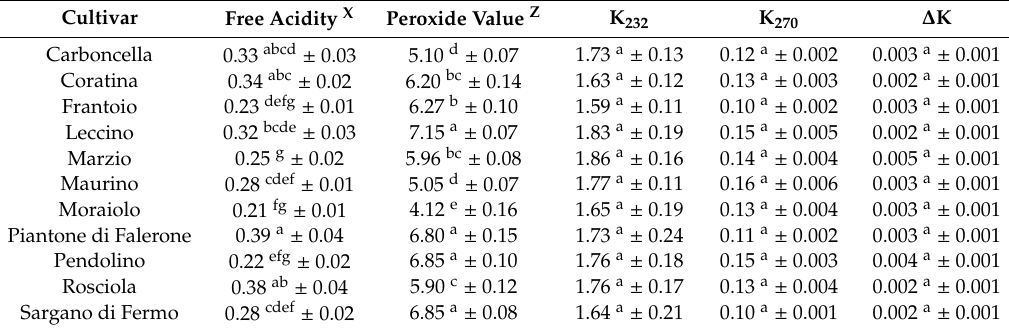
Table 1. Olive oil quality parameters of the eleven monovarietal oils investigated.